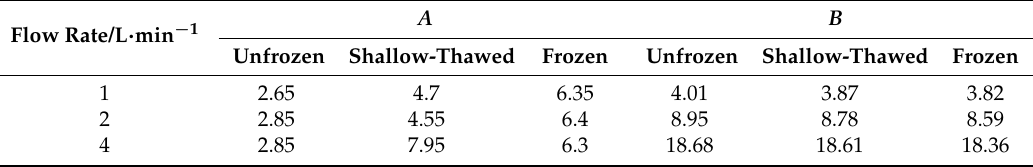
Figure 7. Relationship of the soil erosion rate and the runoff energy consumption at 1 L/min ( a ), 2 L/min ( b ), and 4 L/min ( c ) for unfrozen, shallow-thawed, and frozen slopes. Table 5. Regression parameters between the soil erosion rate and runoff energy consumption for the unfrozen, shallow-thawed, and frozen slopes.